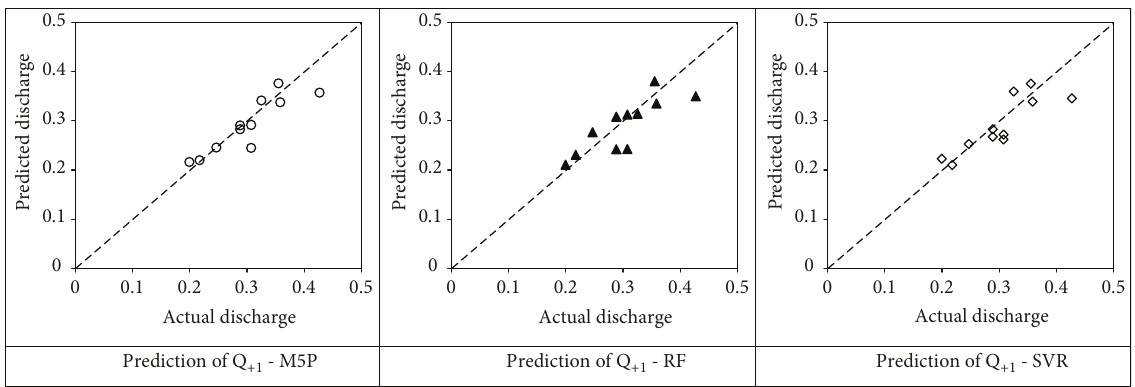
Prediction of Q + 1 - M5P Prediction of Q + 1 - RF Prediction of Q + 1 - Figure 10: Comparison between predicted and observed discharges (m 3 /s), 8-month